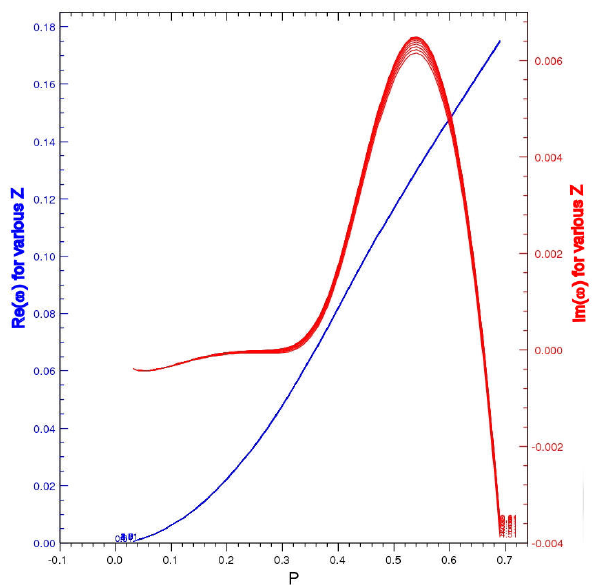
Fig. 7. Results for model 1: Real frequency Re(ω)/(cid:127) e (blue line) and damping/growth rates Im(ω)/(cid:127) e (red line) of the whistler anisotropy instability as function of the modulus of the wave num- ber P = kρ e and for different wave angle (Z) between 0 and 5 ◦ .